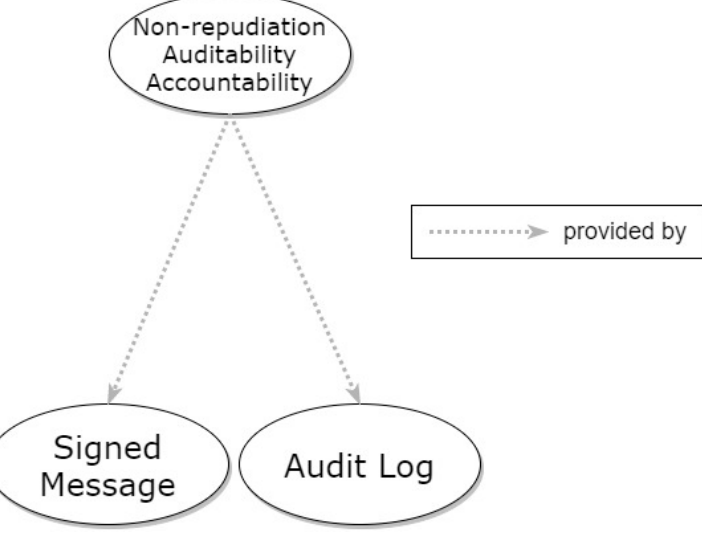
Figure 9. Hierarchical graph of Non-repudiation, Accountability, and Auditability properties and relevant patterns.